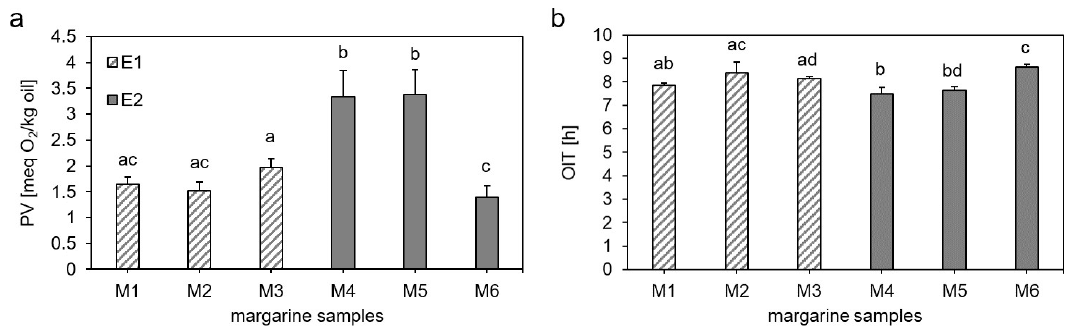
Figure 2. Influence of different emulsifiers on the oxidative stability of margarine determined by the peroxide value ( a ) and oxidation induction time ( b ). M1–M3 consisted of margarines using E1 in commonly applied concentration, 20% lower concentration and 20% higher concentration, respectively. M4–M6 consisted of margarines using E2 in commonly applied concentration, 20% lower concentration and 20% higher concentration, respectively. Data are depicted as mean + SD (n = 4). Statistically significant differences between the margarine samples are indicated with different lower-case letters (one-way ANOVA, Holm–Sidak, p <